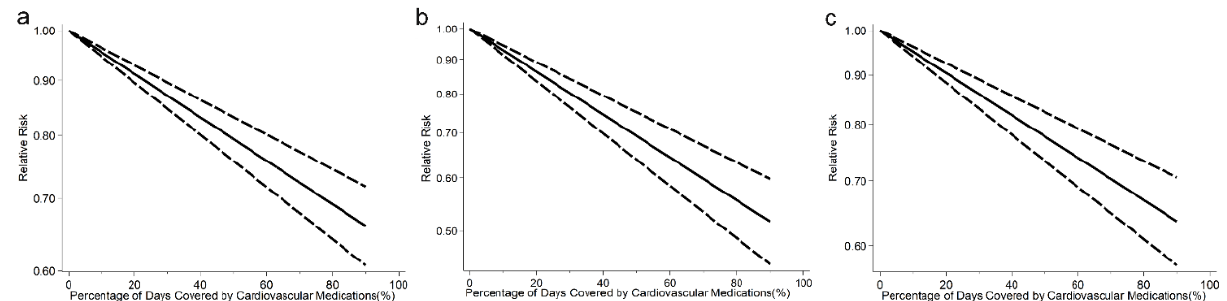
Figure 3. ( a ) Pooled dose-response analysis of cardiovascular medication adherence and cardiovascular events risk (solid line). ( b ) Pooled dose-response analysis of cardiovascular medication adherence and stroke risk (solid line). ( c ) Pooled dose-response analysis of cardiovascular medication adherence and all-cause mortality risk (solid line). Dashed lines represent the 95% CI.